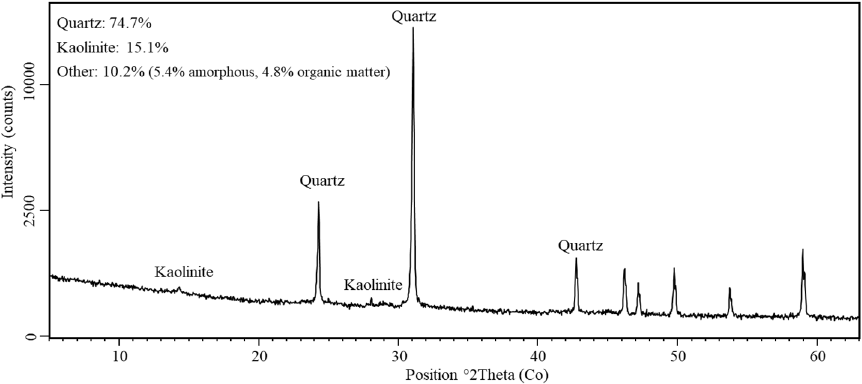
Figure 2. X-ray diffractogram of the Yellow Latosol showing its main constituents, represented by quartz, kaolinite, amorphous phase, and organic matter. quartz, kaolinite, amorphous phase, and organic